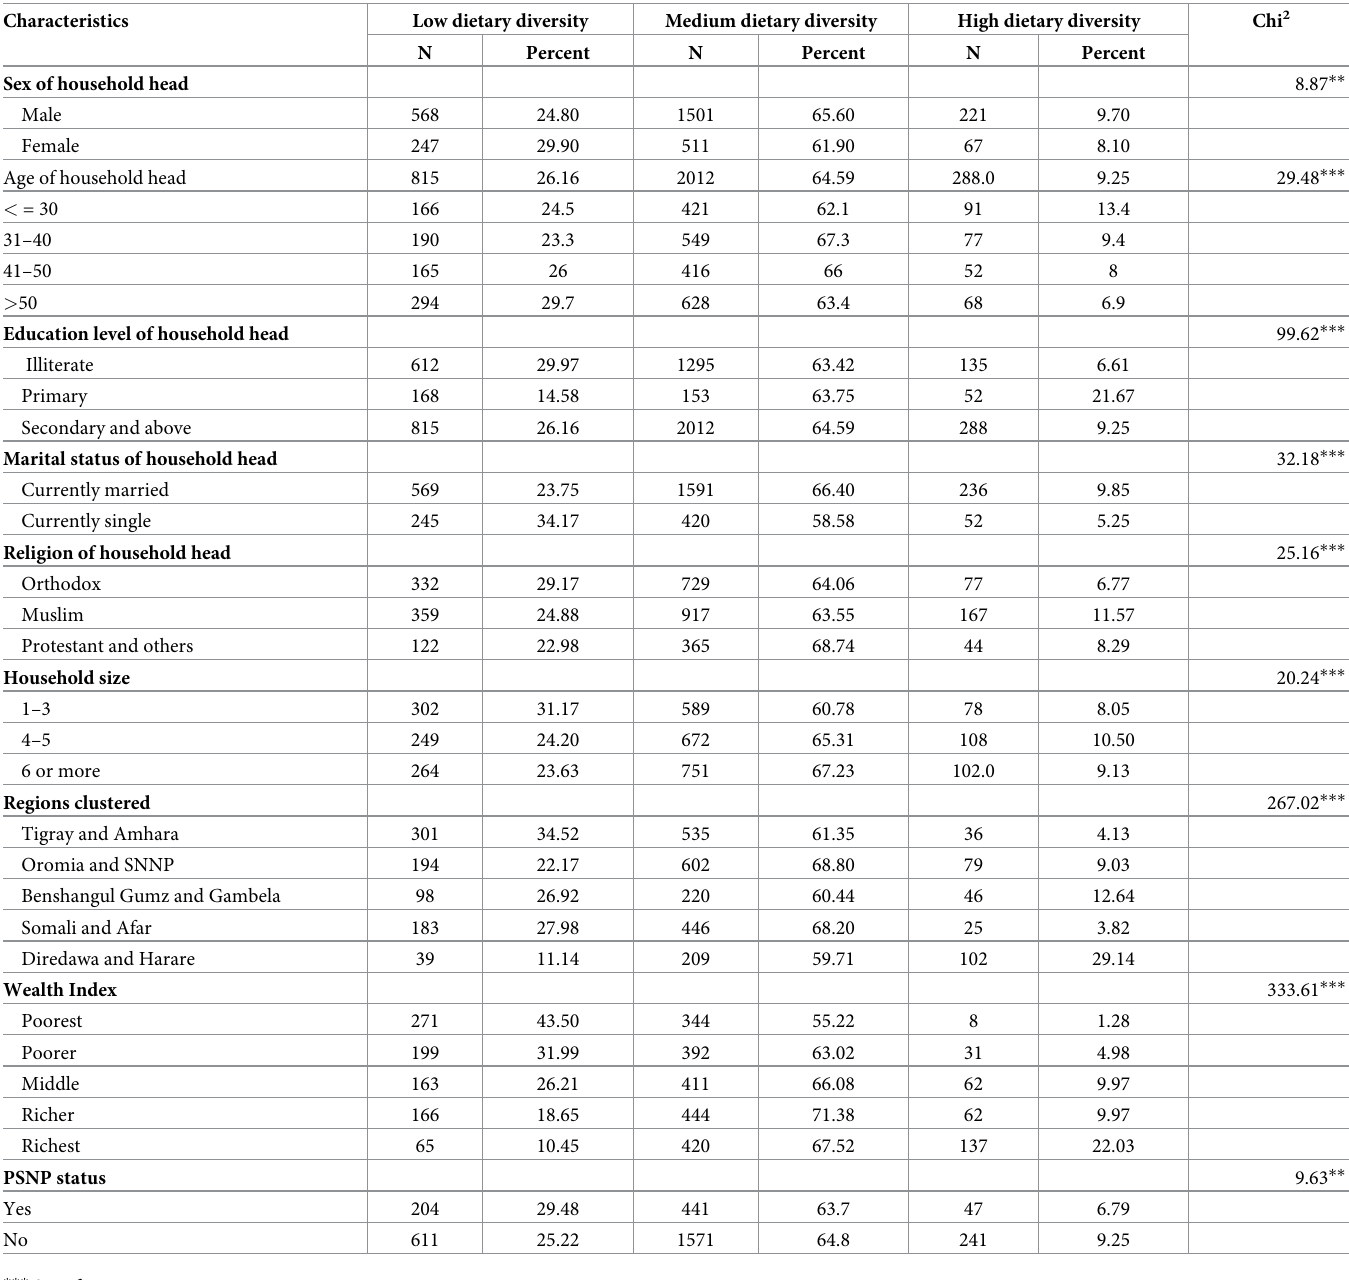
Table 2. Percentage distribution of household DD according to the characteristics of the study respondents and households, Ethiopia, 2018/19.